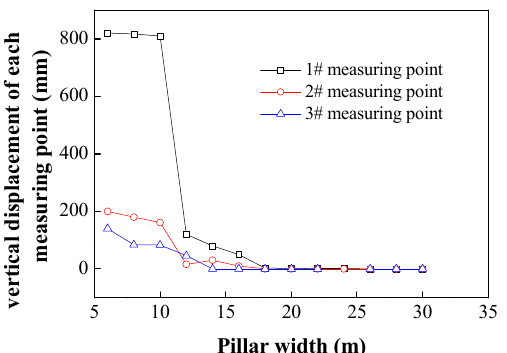
Figure 9. Relationship curve between the vertical displacement of each measuring point and width of coal